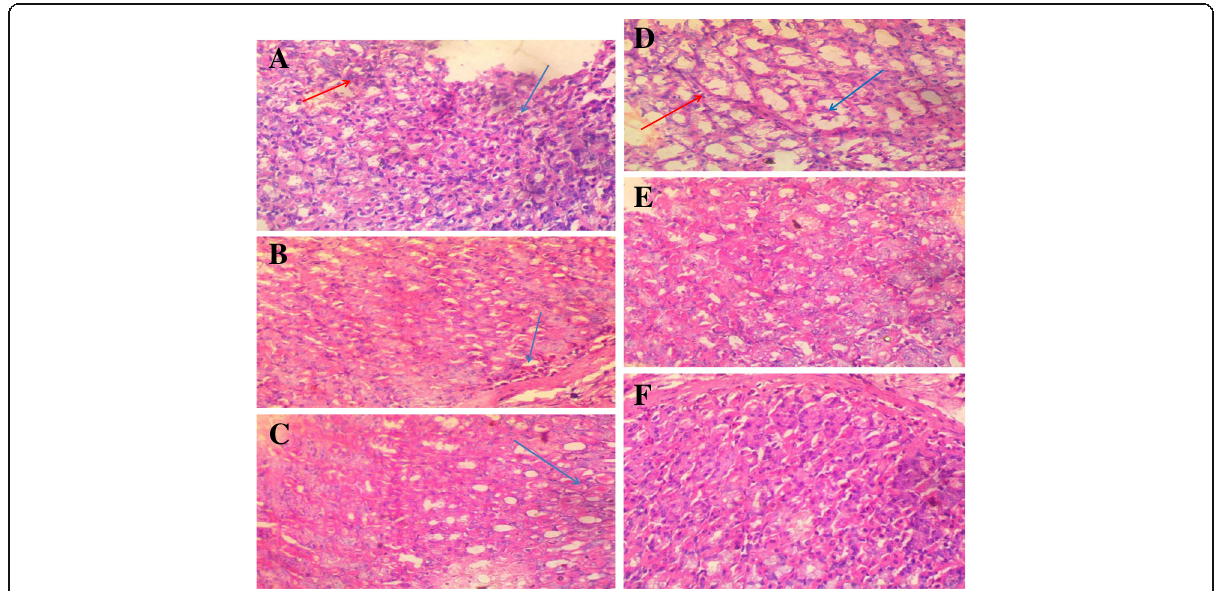
Fig. 7 a The basal control group, magnification of × 100. b Negative control, magnification of × 400. c The positive control, magnification of × 400. d Effects of the pre-treatment of 50 mg/kg Sorghum bicolor flavanone (SBFE) on the gastric tissue of HCl/ethanol-induced inflammation in rats, magnification × 400. e Effects of the pre-treatment of 100 mg/kg Sorghum bicolor flavanone (SBFE) on the gastric tissue of HCl/ethanol- induced inflammation in rats, magnification × 400. f Effects of 100 mg/kg Sorghum bicolor flavanone extract (SBFE) only on the gastric tissue of the experimental animals, magnification × 100